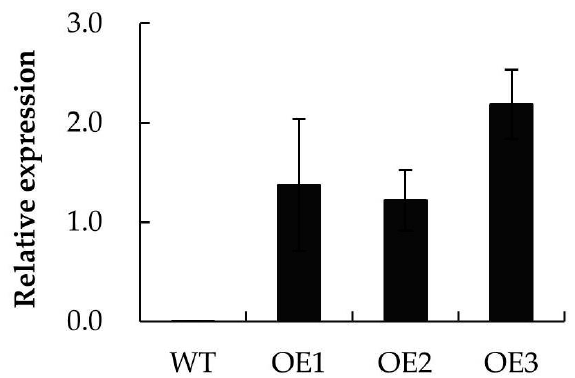
Figure 6. Relative expression of MpPIP2;1 in three A. thaliana transgenic lines heterologously expressing MpPIP2;1 using qRT-PCR with Col-0 as control. The value presented was the mean ± SD of three replicates.